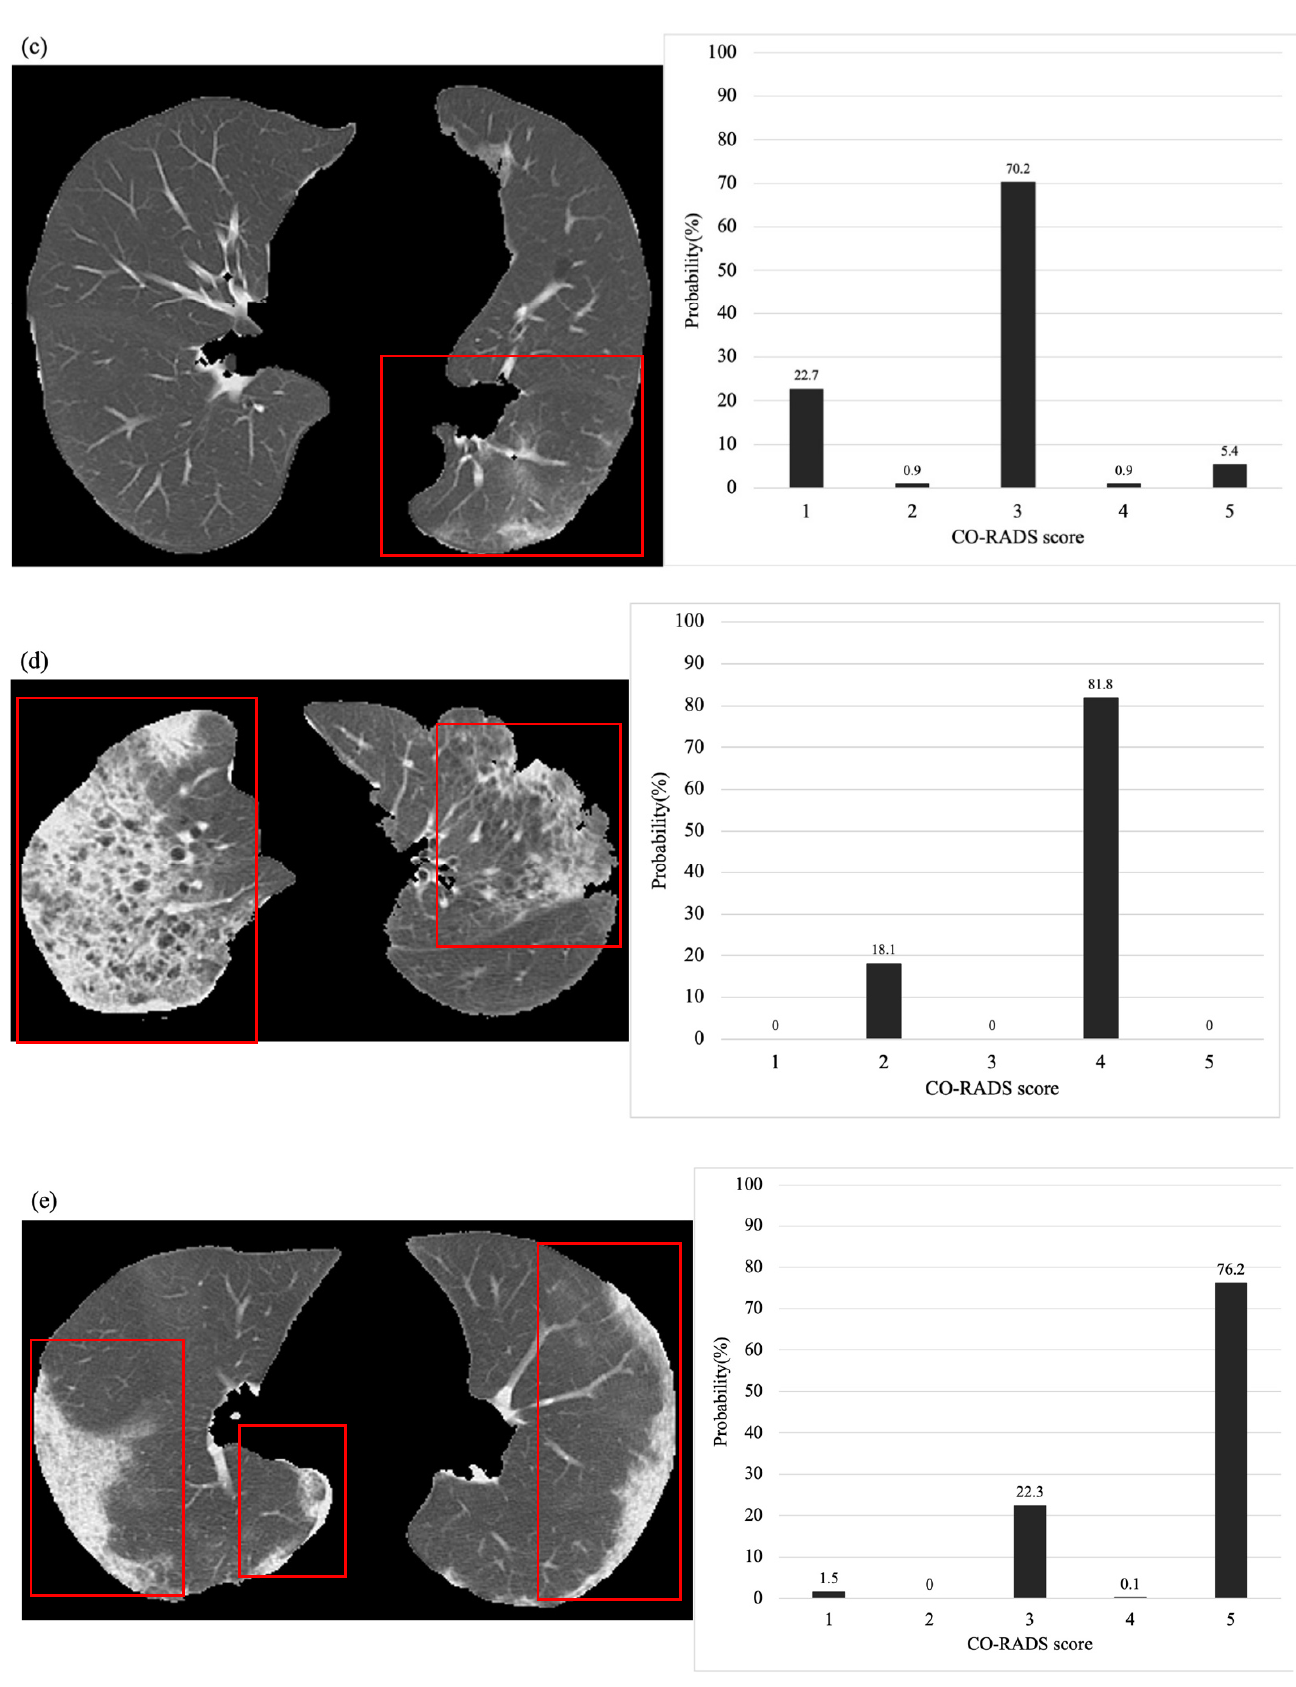
Figure 4. Representative output from the classification model. ( a ) The CT image shows no abnormal density in both lungs. The classification model presented a 100% probability of a CO-RADS score of 1. ( b ) CT imaging shows multiple centrilobular nodules in both lungs. The classification model pre- sented an approximately 99% probability of obtaining a CO-RADS score of 2. ( c ) The CT images show unilateral nonspecific ground-glass opacity in the dorsal aspect of the left lung. The classifi- cation model presented an approximately 70% probability of obtaining a CO-RADS score of 3. Alt- hough a score of 3 was determined, the possibility of 1 or 5 was also suggested. ( d ) CT imaging shows bilateral subpleural predominant ground-glass opacity and consolidation and strong emphy- sematous changes in the background. In classification models, a CO-RADS score of 4 is most likely. ( e ) The CT image shows crazy-paving-like ground-glass opacity in the bilateral subpleural areas. The classification model also presents the highest possibility of a CO-RADS score of 5. 3.2. Deep-Learning Model and Validation The data of 412 patients (10,510 images) were classified into the training (90%) and validation (10%) datasets using the hold-out method, and the model was constructed and validated in 4 h. The accuracy of the constructed model was 99.5% and 98.6% for the train- ing and validation datasets, respectively. There was no sign of overfitting, as the plots of training loss and validation loss decreased to a stable point, with a small gap between them (Figure 5).